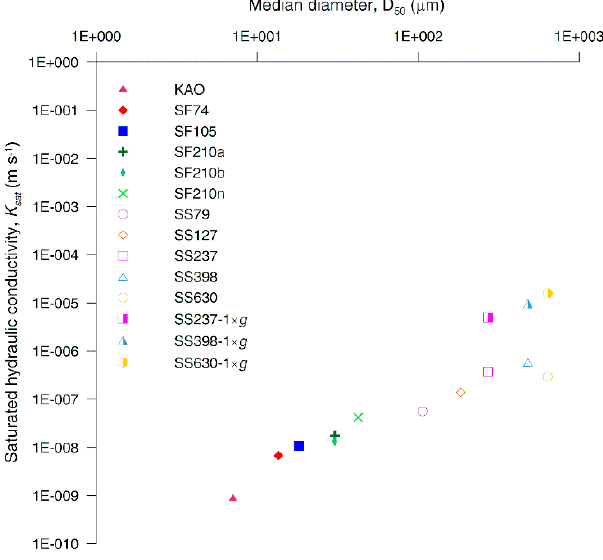
Figure 4. Saturated hydraulic conductivity, K sat , as a function of the measured median diameter, D 50 , of flow-control granular material.